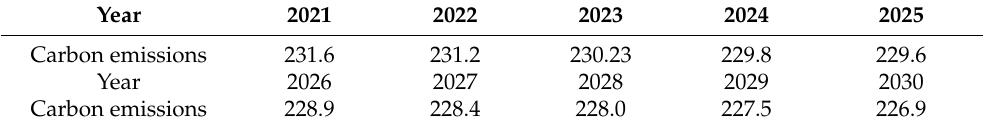
Table 4. The predicted value of industrial carbon emission in Nanjing from 2021 to